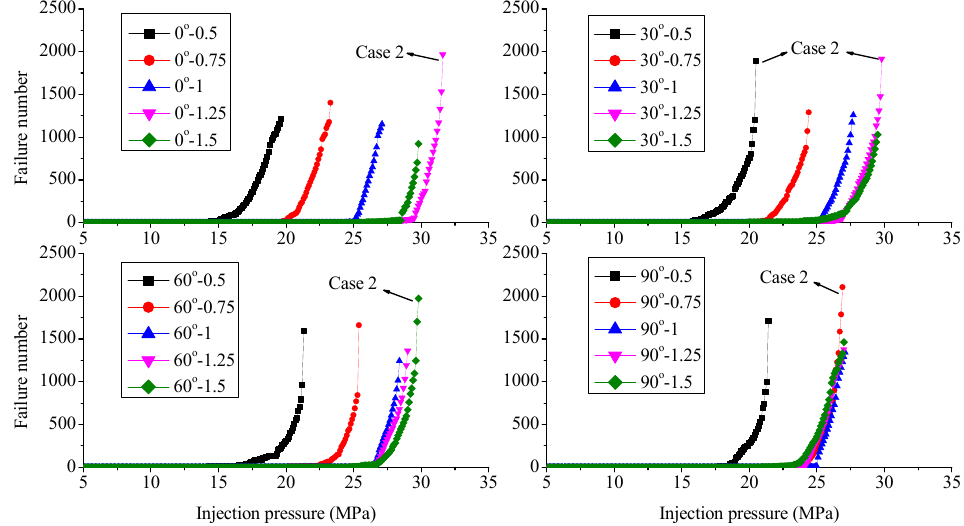
Figure 17. Change of failure number in bedding shale during nitrogen fracturing.